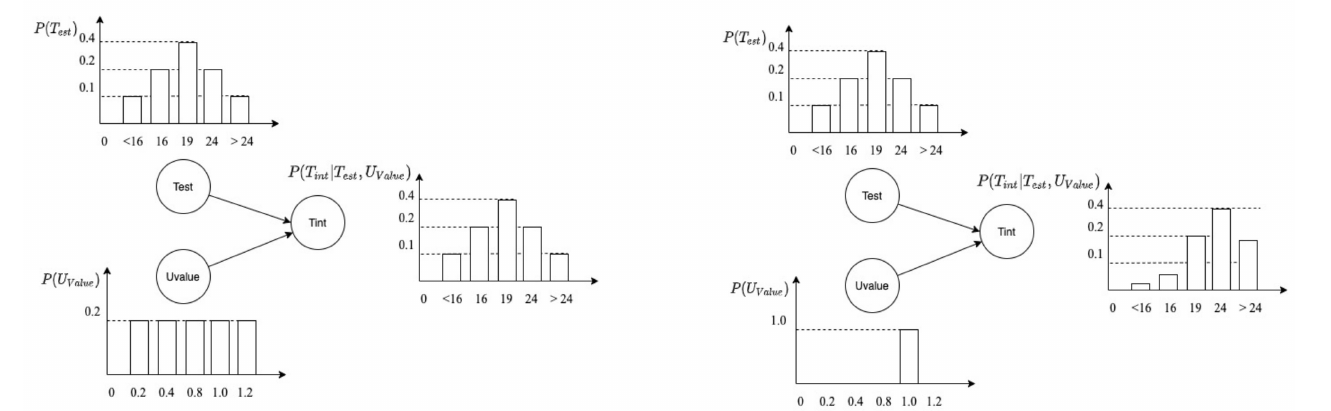
Figure 7. Example of Bayesian network.